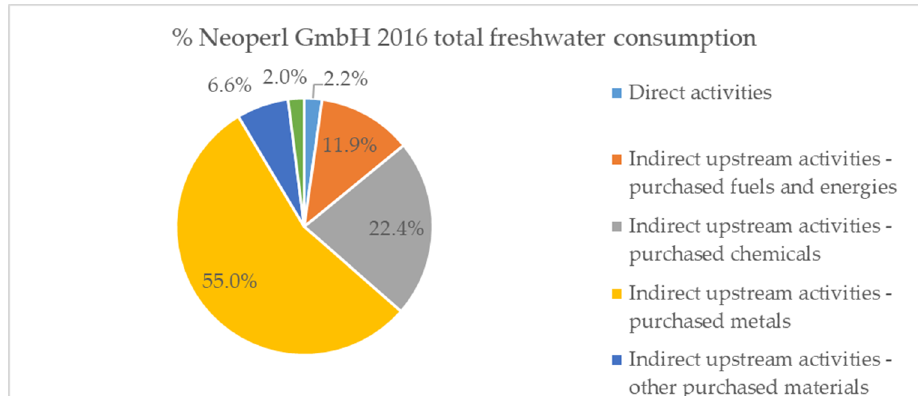
Figure 3. Activity contributions to Neoperl’s blue freshwater consumption.